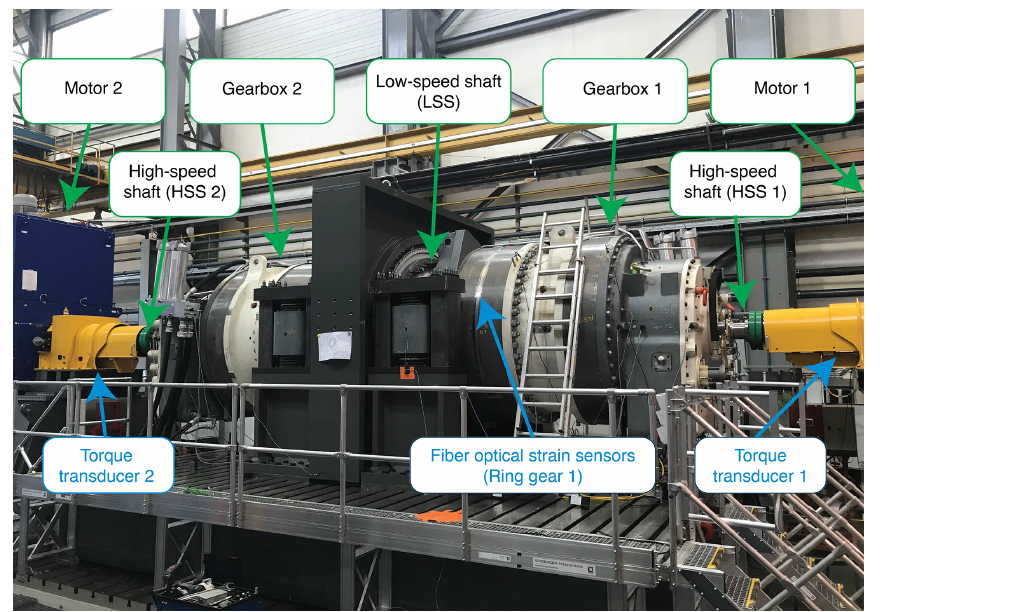
Figure 3. SGRE gearboxes on a back-to-back test bench (property of DMT GmbH & Co. KG). The first-stage ring gear of gearbox 1 was instrumented with fiber-optic strain sensors.